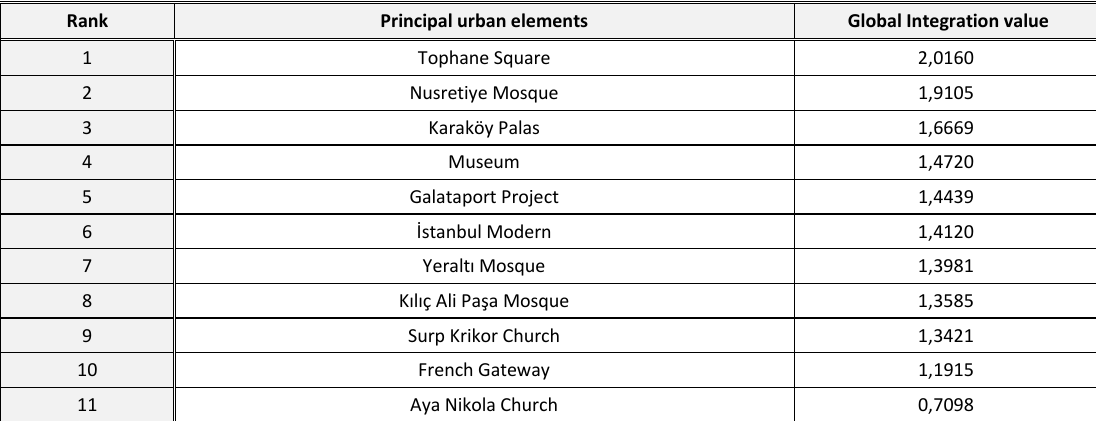
Figure 17 The rank ordering of the major urban space and urban elements of the study area. Table 4 The rank ordering of the major urban space and urban elements of the study area by the value of global